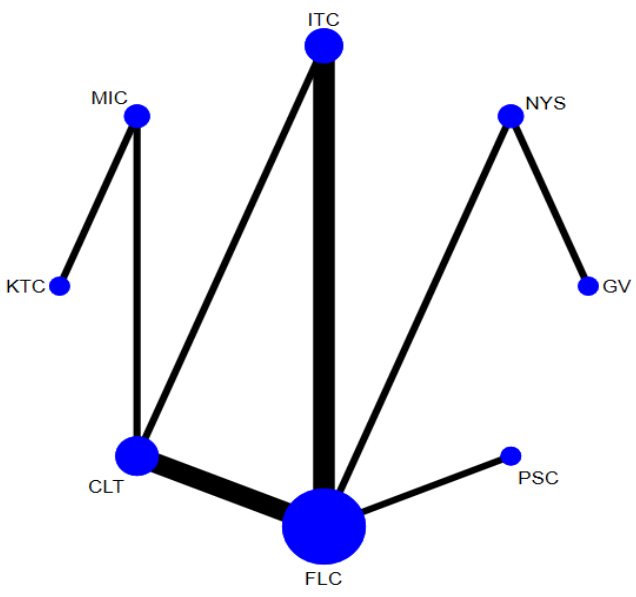
Figure 9. Network plot of trials comparing the safety of antifungal agents used for the treatment of OPC among HIV-infected adults. Abbreviations: CLT — clotrimazole, FLC — fluconazole, GV — gen-